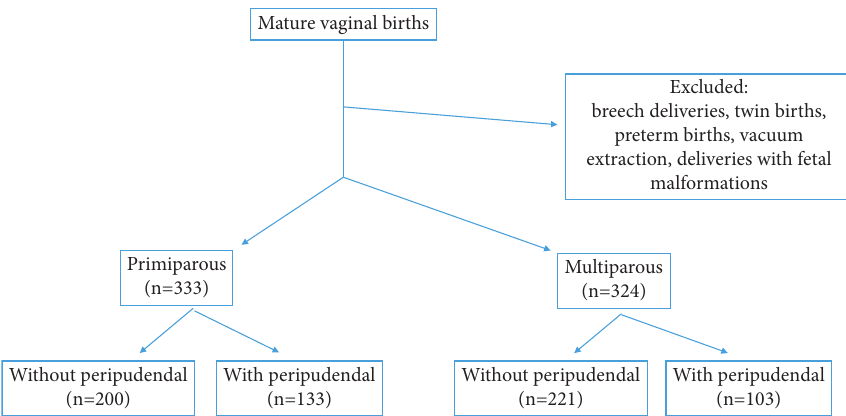
Figure 1: Flow diagram of the study.